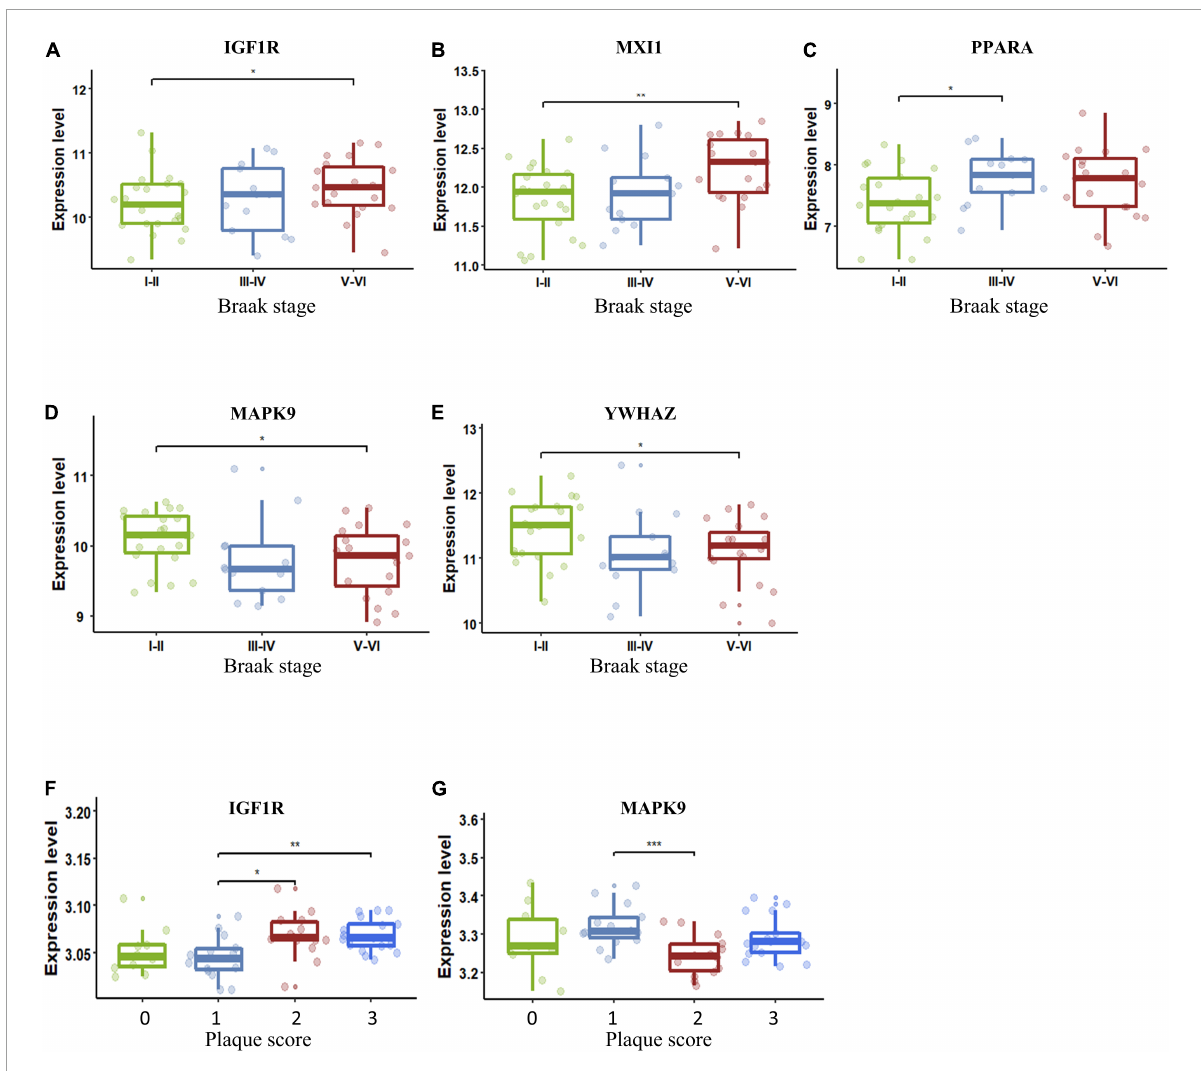
FIGURE6 Key AG expression levels in AD patients with different Braak stages or plaque scores. (A) The expression of IGF1R in different Braak stages of AD. (B) The expression of MXI1 in different Braak stages of AD. (C) The expression of PPARA in different Braak stages of AD. (D) The expression of MAPK9 in different Braak stages of AD. (E) The expression of YWHAZ in different Braak stages of AD. (F) The expression of IGF1R in different plaque scores of AD. (G) The expression of MAPK9 in different plaque scores of AD. The upper, lower, and middle horizontal lines of the box represent the upper, lower, and median quartiles, respectively. The t -test was used to estimate whether differences between the two groups were significant. Asterisks denotes significant difference. p -value: * p < 0.05; ** p < 0.01; *** p < 0.001. AD, Alzheimer’s disease; AG, aging-related